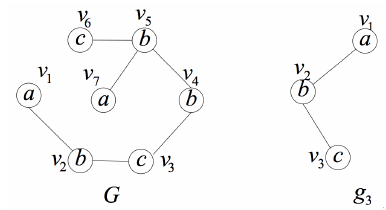
Figure 9. The importance of matching the query position